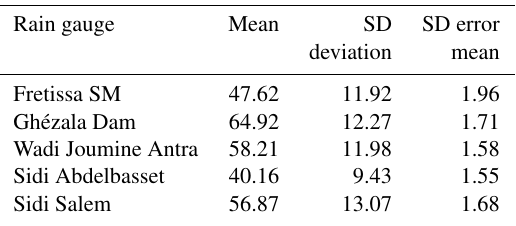
Table 2. Descriptive statistics for the maximum yearly rainy days at growing time.